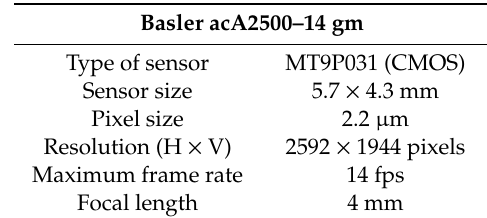
Table 1. Technical specifications of the photographic sensors. CMOS—complementary metal–oxide– semiconductor.